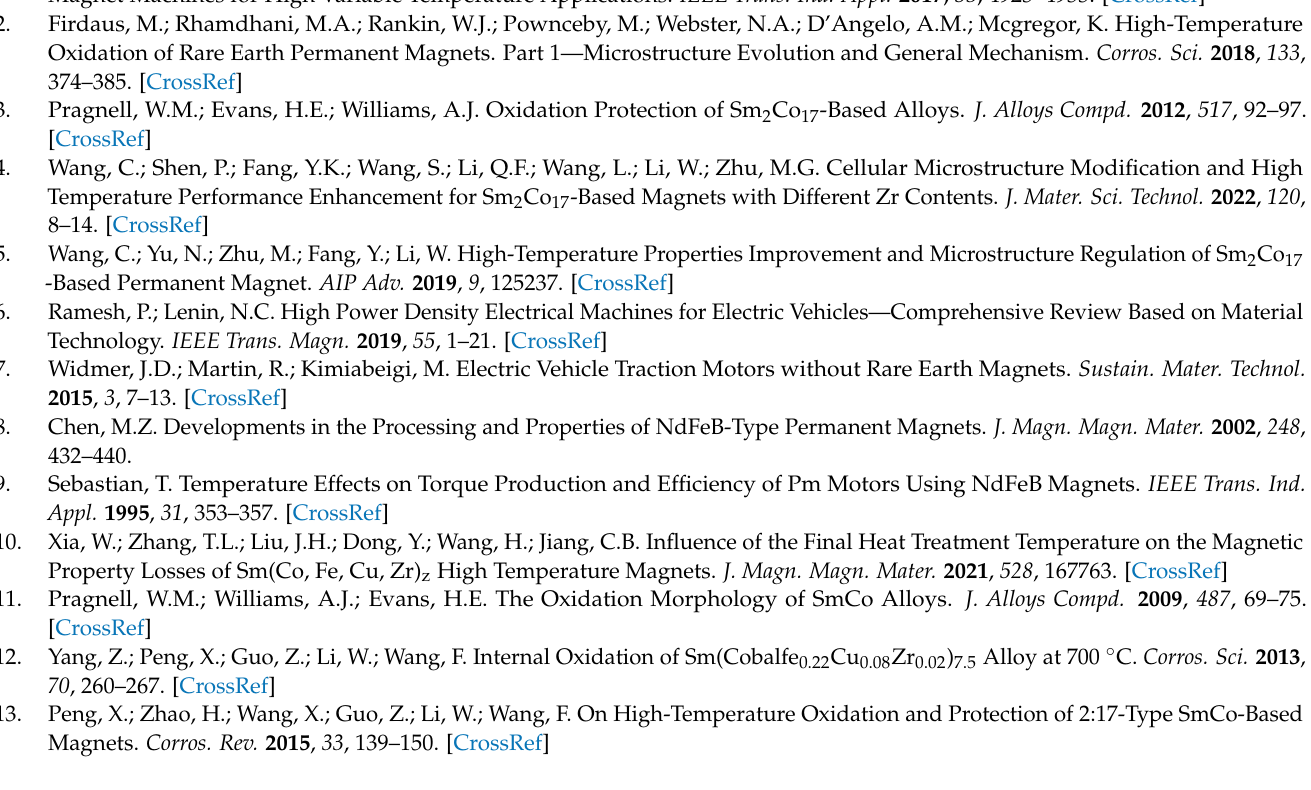
Table S4: The Φ and their losses of samples recycled in the range of R.T. to 180 ◦ C, 250 ◦ C, and 300 ◦ C, respectively; Table S5: The Φ and their losses of samples after oxidation in air at 80, 120, and 180 ◦ C for different days, respectively. Figure S1: Variation trends of (a) Φ , (b) The fitting curve of the loss of Φ during recycling between the R.T. and 180 ◦ C, and between the − 50 ◦ C and 180 ◦ C for 125 cycles, respectively; Figure S2: Variation trends of Φ of (a) untreated and (b) pretreated samples after oxidation in air at 80, 120, and 180 ◦ C for 180 days,